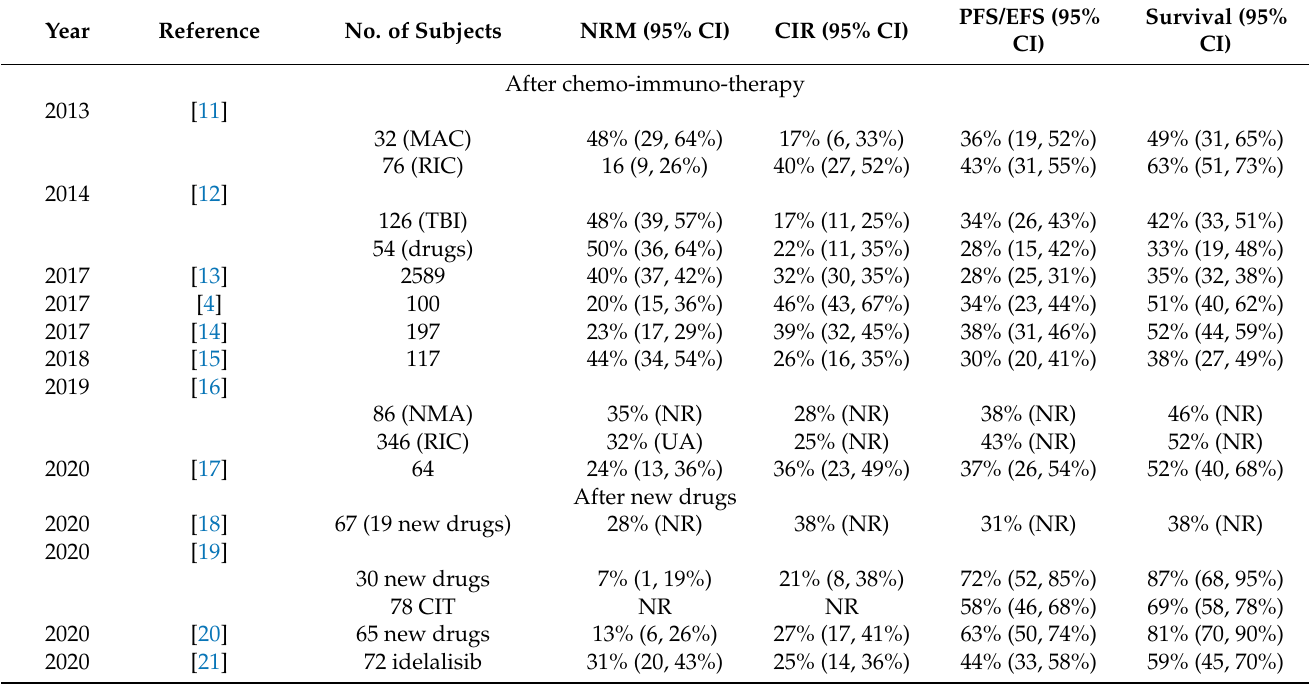
Table 1. Transplant outcomes in studies with ≥ 50